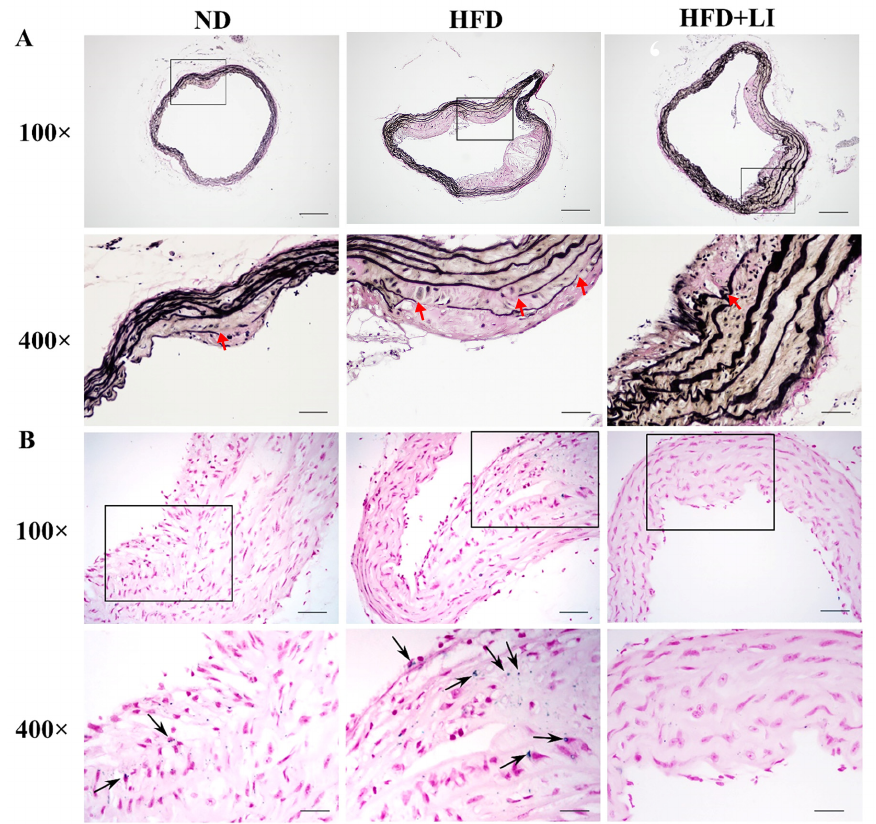
Figure 3. Characterization of aortic elastic fibers and iron deposition in ApoE KO mice according to each diet group. ( A ) Voerhoff von Gieson staining of mice aortic tissues. ( B ) Prussian blue staining of murine aortic tissue sections assessed iron deposition in atherosclerotic plaques (n = 4). Arrowheads indicate positive staining areas. Images are shown at 100 × and 400 × magnification. Scale bar for 100 × = 200 µ m; scale bar for 400 × =50 µ m. ND: normal diet, HFD: high-fat diet, HFD + LI: high-fat diet without iron supplementation.